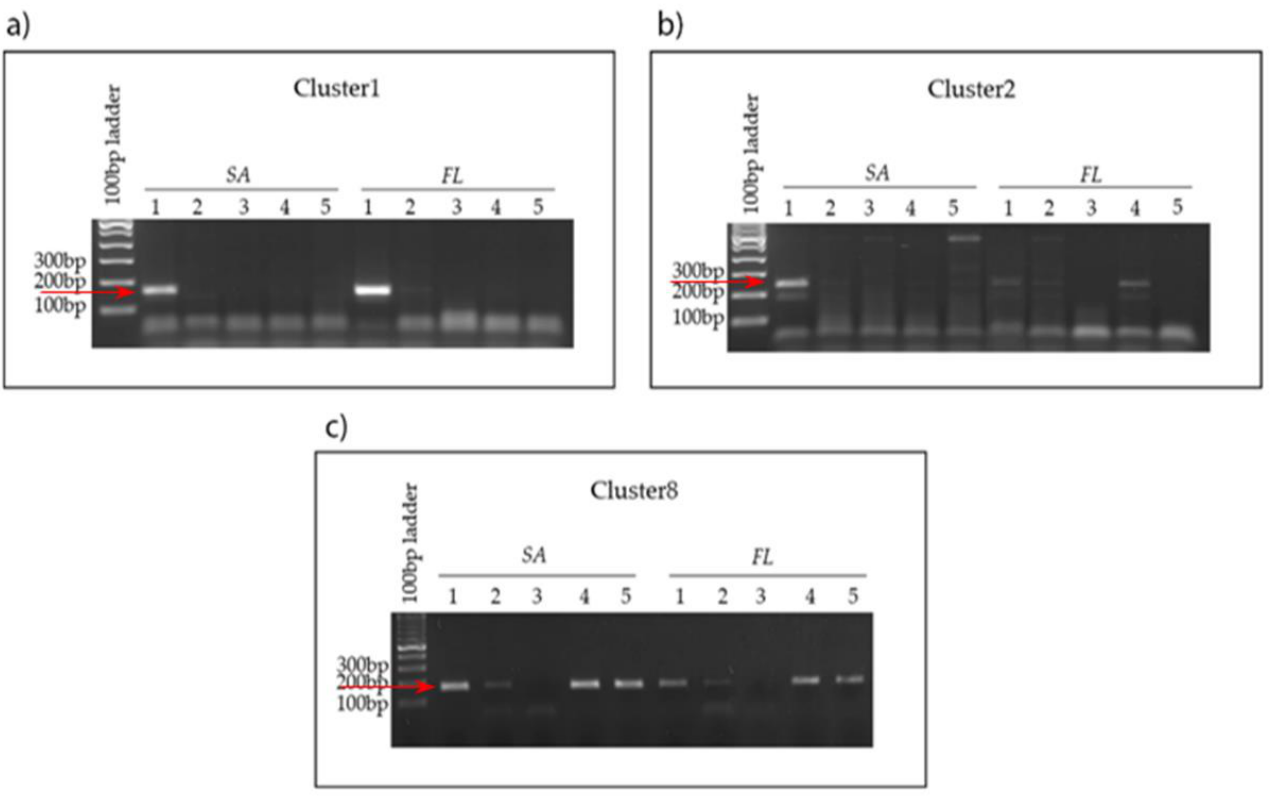
Figure 9. MAG antibiotic tolerance in strictly associated (SA) and free-living (FL) fractions. ( a ) Cl-1. ( b ) C-2 ( c ) Cl-8 detection in the presence of different antibiotic (Abt) mixtures and concentrations. Lanes 1, no Abt; lanes 2, 500 mg/mL Amp, 10 mg/mL Ctx (ACx2); lanes 3, 500 mg/mL Amp, 50 mg/mL Str, 10 mg/mL Ctx (ASCx2); lanes 4, 250 mg/mL Amp, 5 mg/mL Ctx (ACx1); lanes 5, 250 mg/mL Amp, 25 mg/mL Str, 5 mg/mL Ctx (ASCx1). Red arrows indicate expected amplicon size.